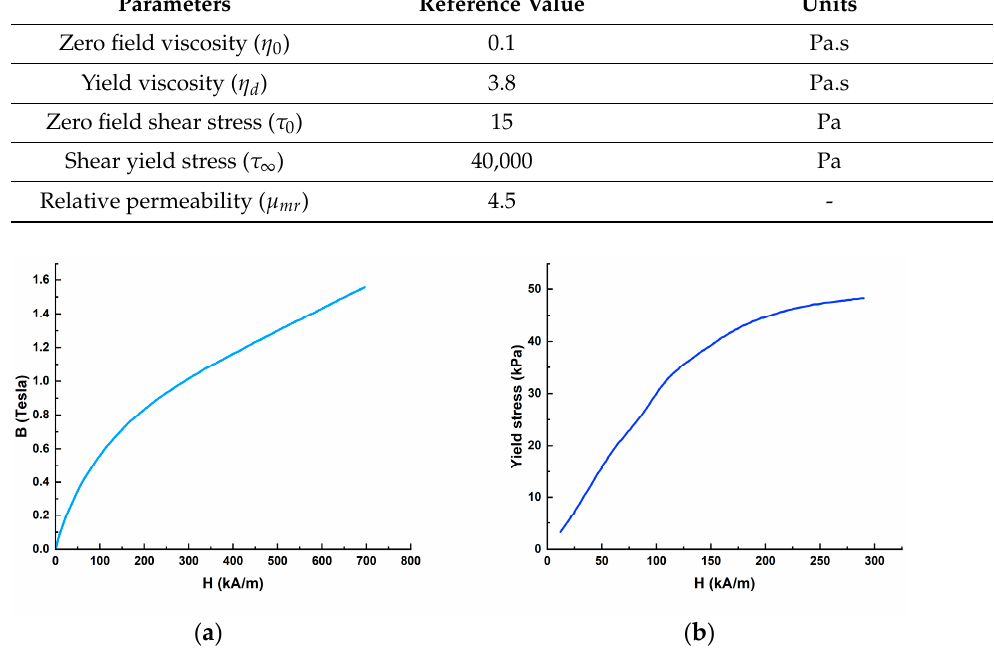
Figure 2. Material properties of MRF-132DG: ( a ) B–H curve; ( b ) the relationship between magnetic fi eld strength and yield stress.